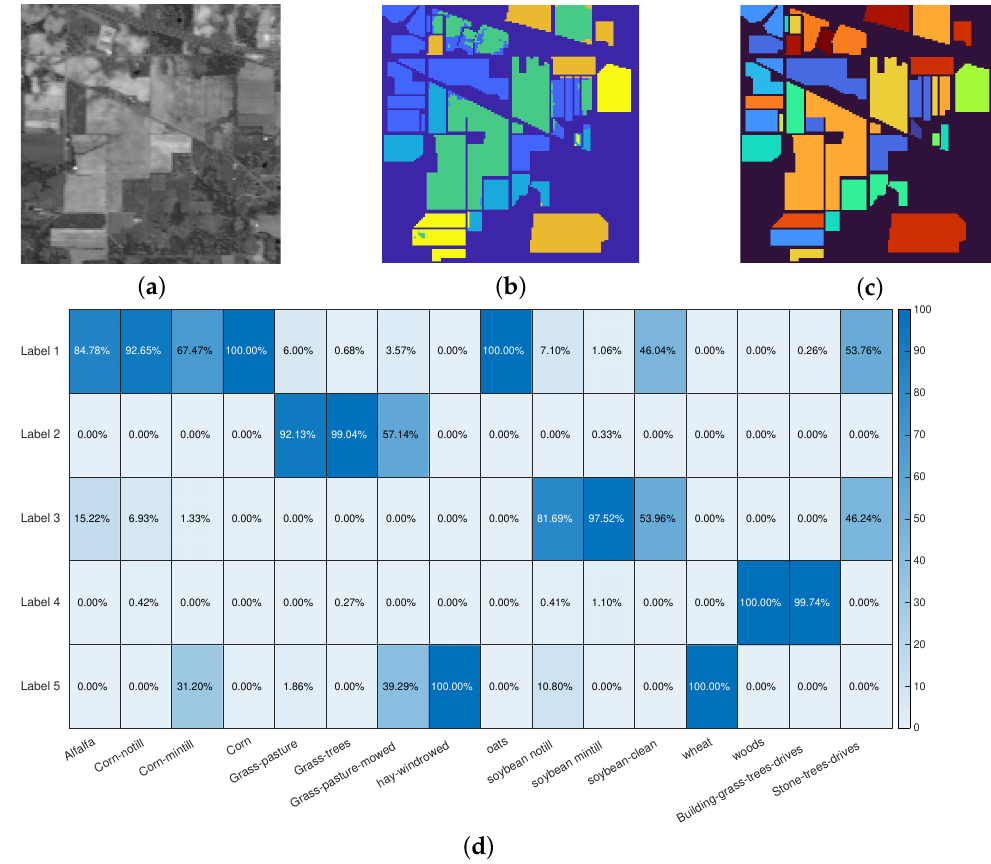
Figure 3. Indian Pines segmentation results. ( a ): false gray scale image. ( b ): segmentation result. ( c ): true labels. ( d ): accuracy over the classes. The colormaps in ( b , c ) are different because the segmentation process takes into account 5 labels, while the ground truth contains 16 labels. Each region in the ground truth falls almost entirely in one of the 5 manually selected labels.